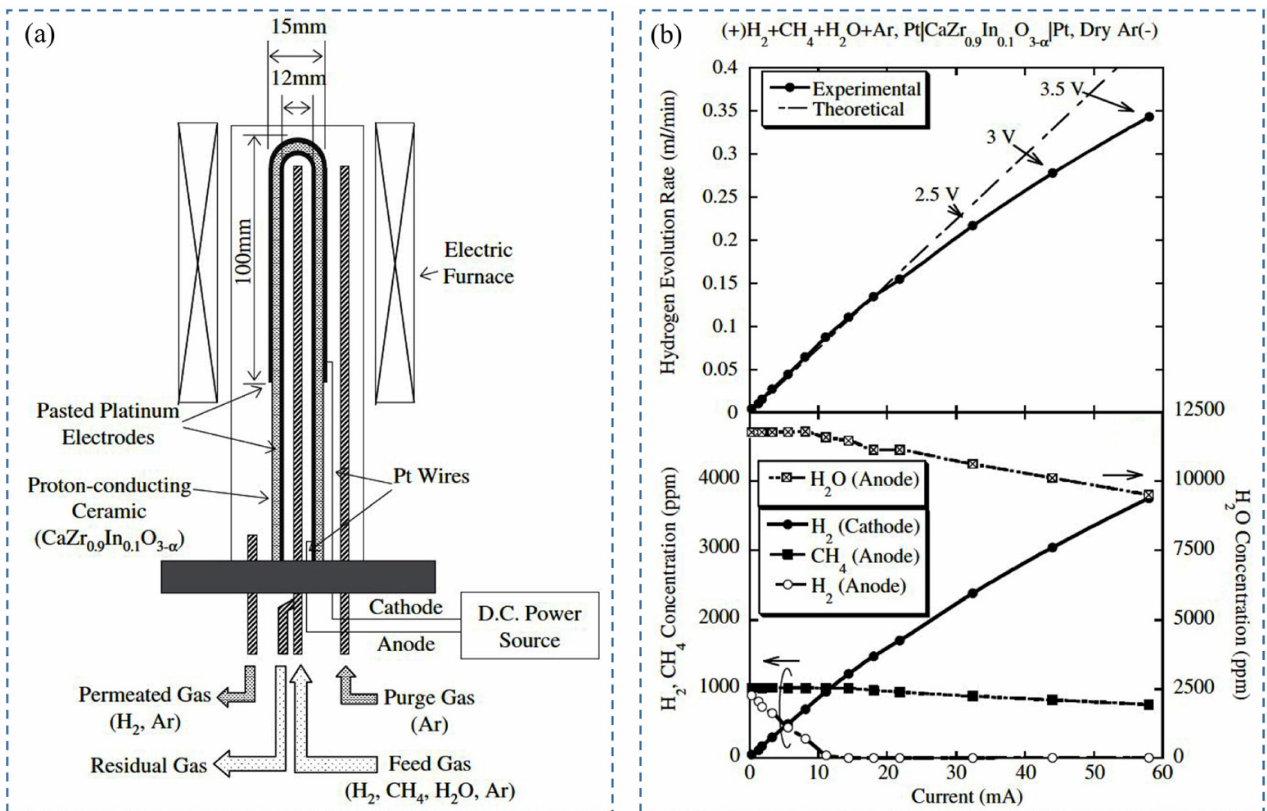
Figure 6. ( a ) A schematic representation of hydrogen extraction system with proton-conducting ceramic on one end, ( b ) response of hydrogen evolution rate (top panel) and hydrogen, methane, and water vapor concentration (bottom panel) as a function of current. Reprinted with permission from Ref. [93]. Copyright 2004 Taylor & Francis.